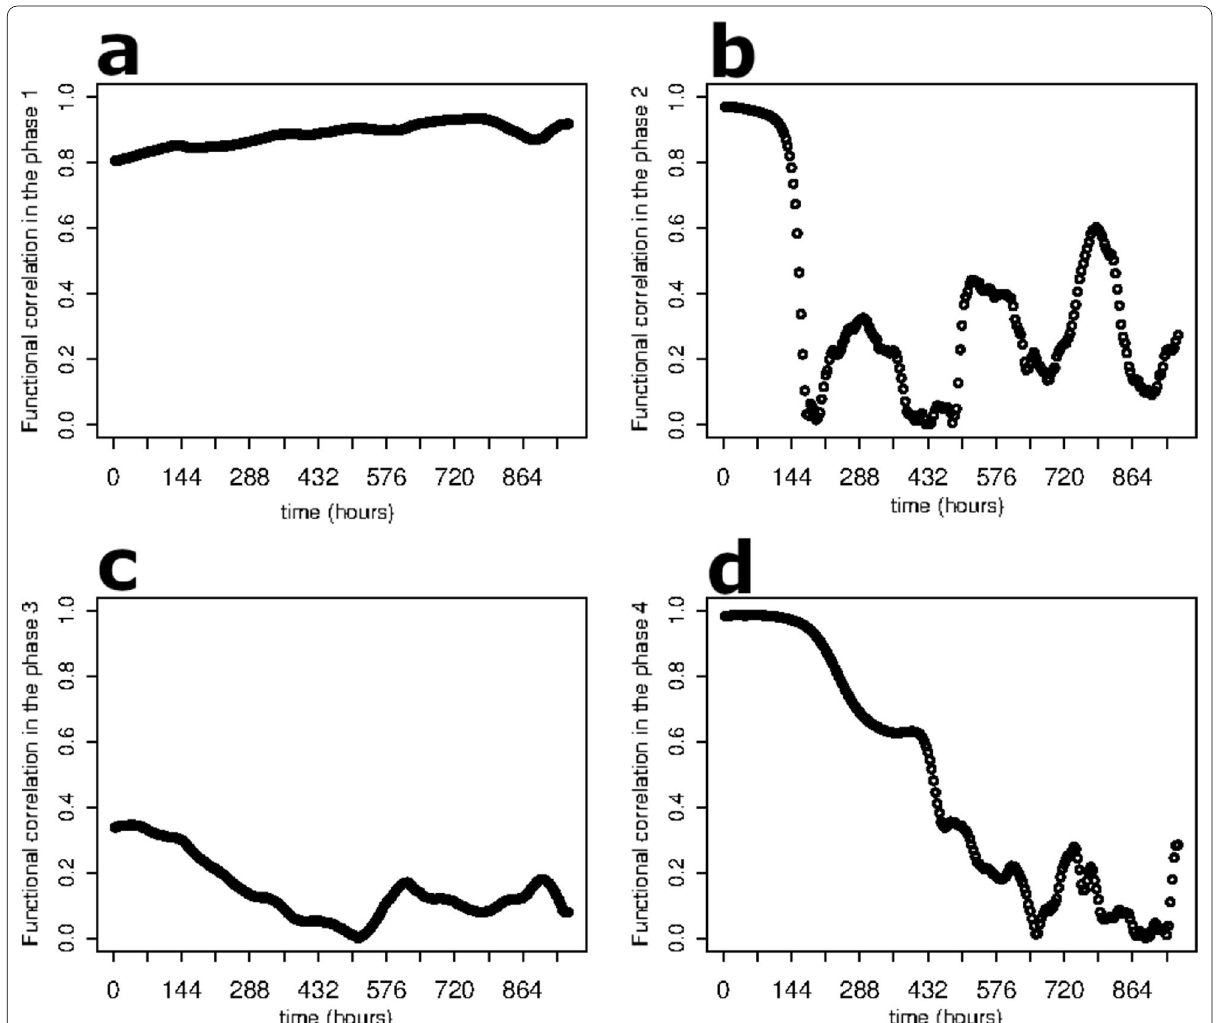
Fig. 10 Correlations in absolute value between the standardized cumulative energy released curve and the surface deformation curve, moving the last curve among 0 and 400 h in the different phases. Figure shows high values of maximum correlation in all phases except for the third phase. The maximum correlation values are shown in Table 1